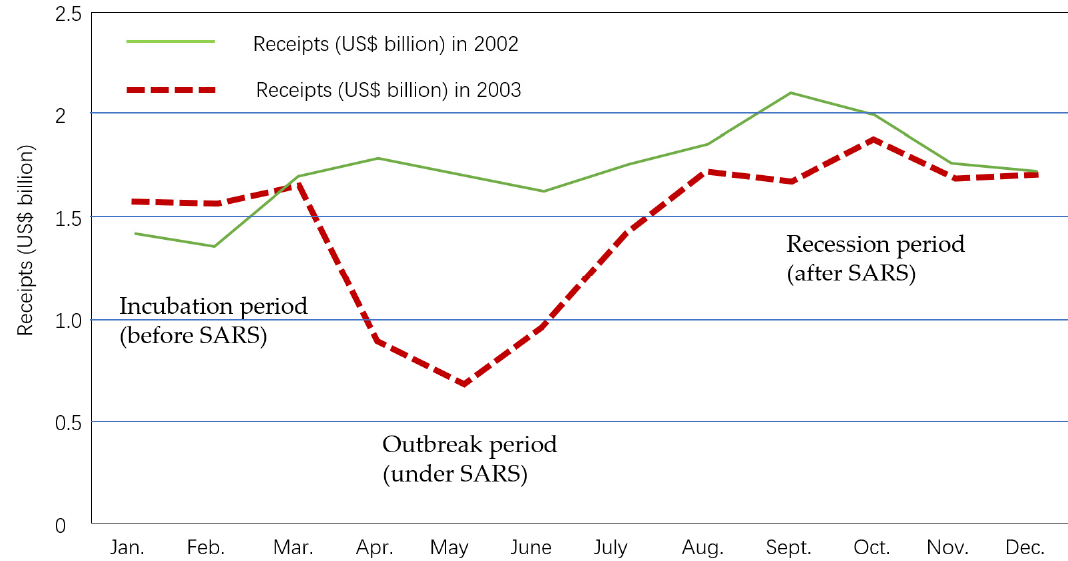
Figure 2. The impact of SARS on Chinese tourism between 2002 and 2003 [12].